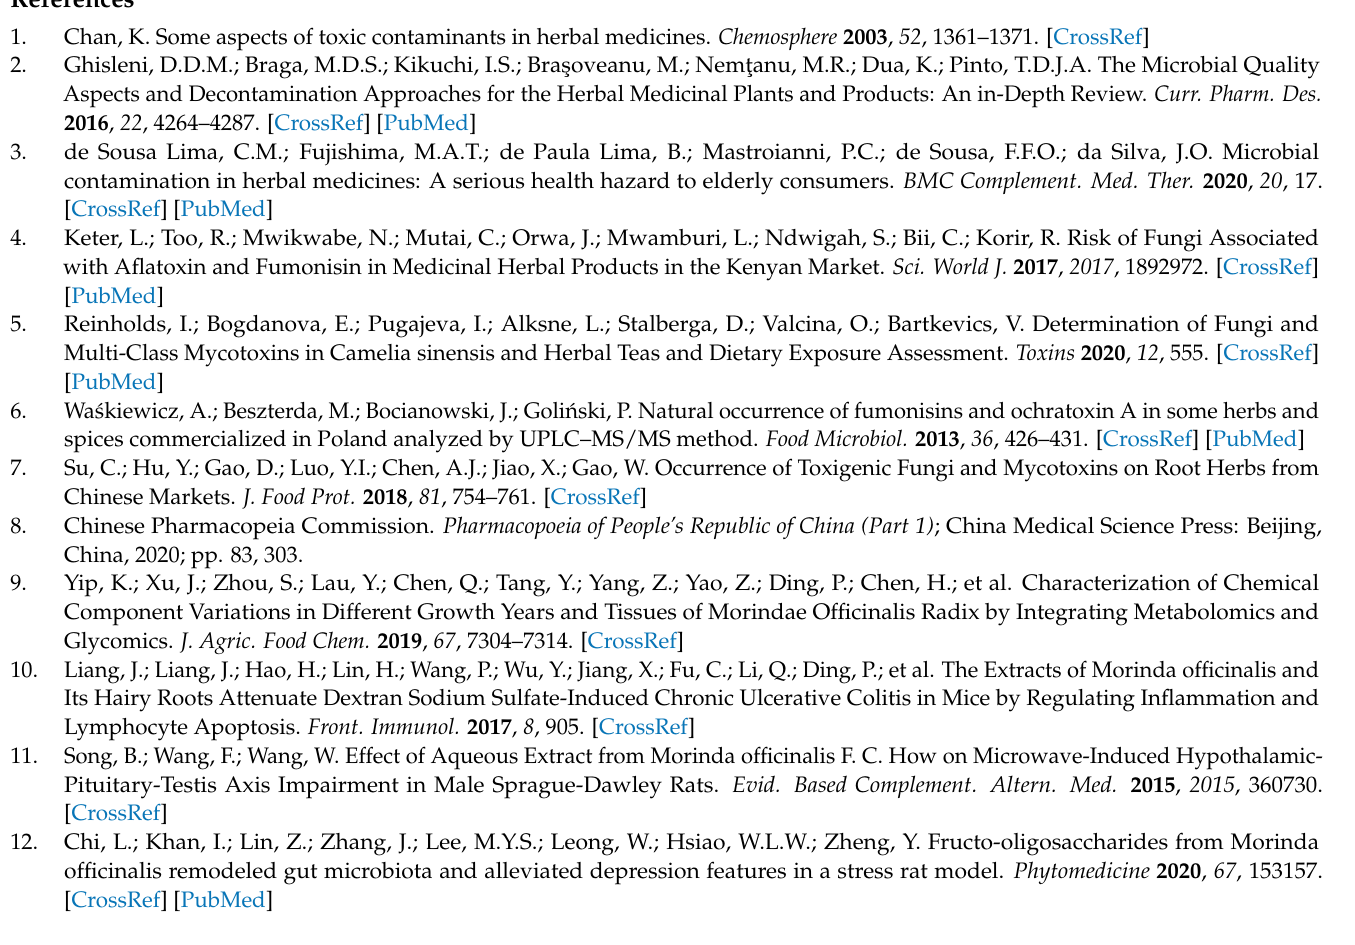
Table S2: The species and relative abundance of potential toxigenic fungi in each